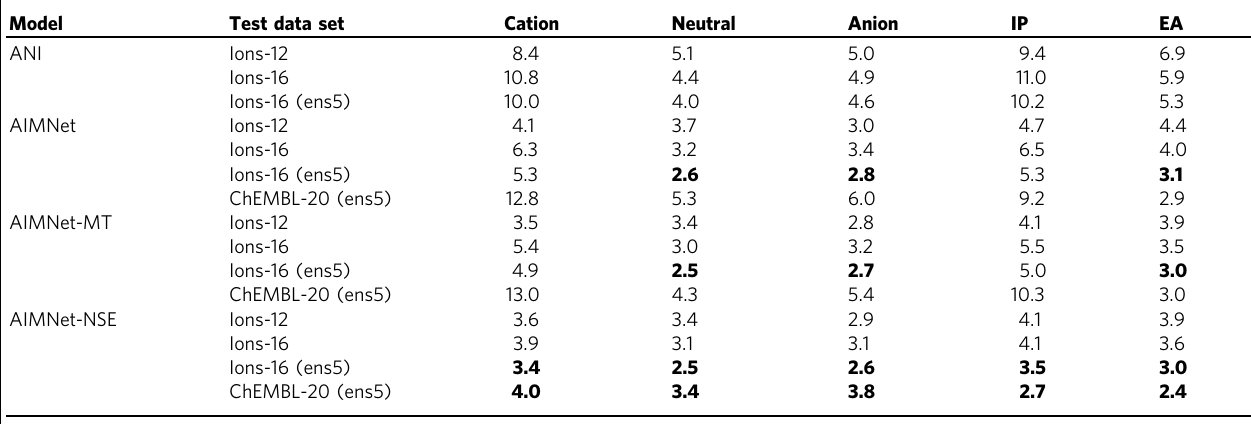
Table 1 Root-mean-square errors (RMSEs) in kcal/mol for total molecular energies and vertical ionization potentials (IP) and electron af fi nities